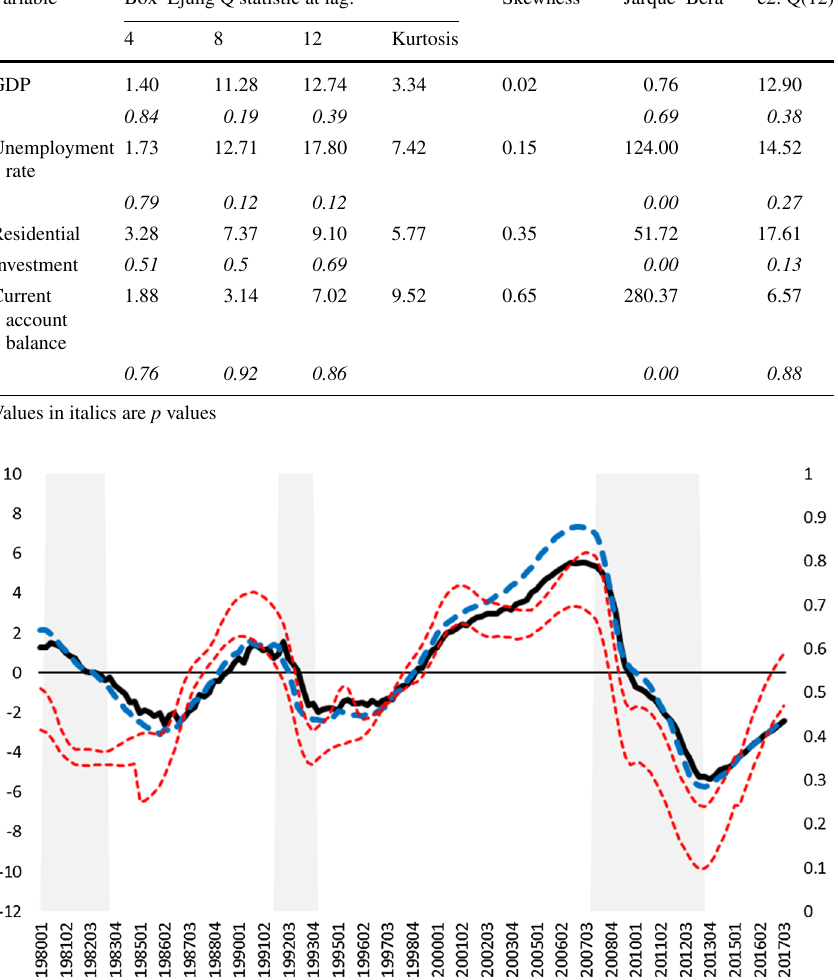
Table 4 Diagnostics for the multivariate (v4) model Source of data : author’s estimations Variable